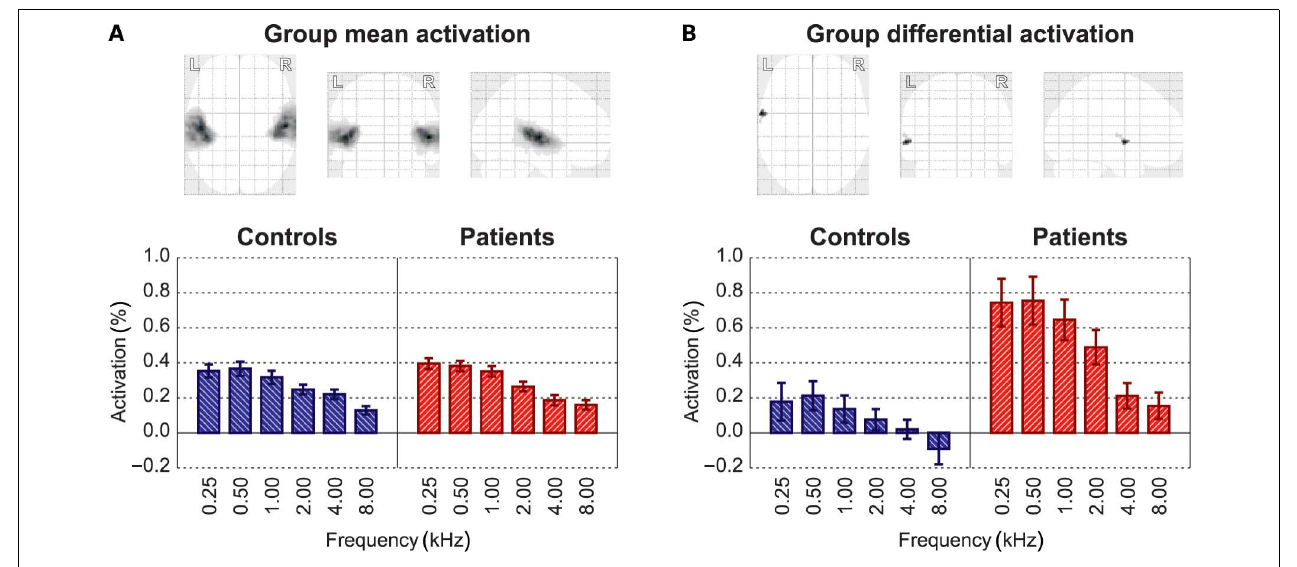
Error bars indicate standard errors of the mean across subjects. (B) Testing for any differences between groups in the frequency-dependent sound-evoked activation profile (thresholded at p < 0.05, FWE-corrected, and minimum cluster size of 20 voxels) revealed one cluster in left lateral Heschl’s gyrus.The bar plot shows the mean response levels for this subset of